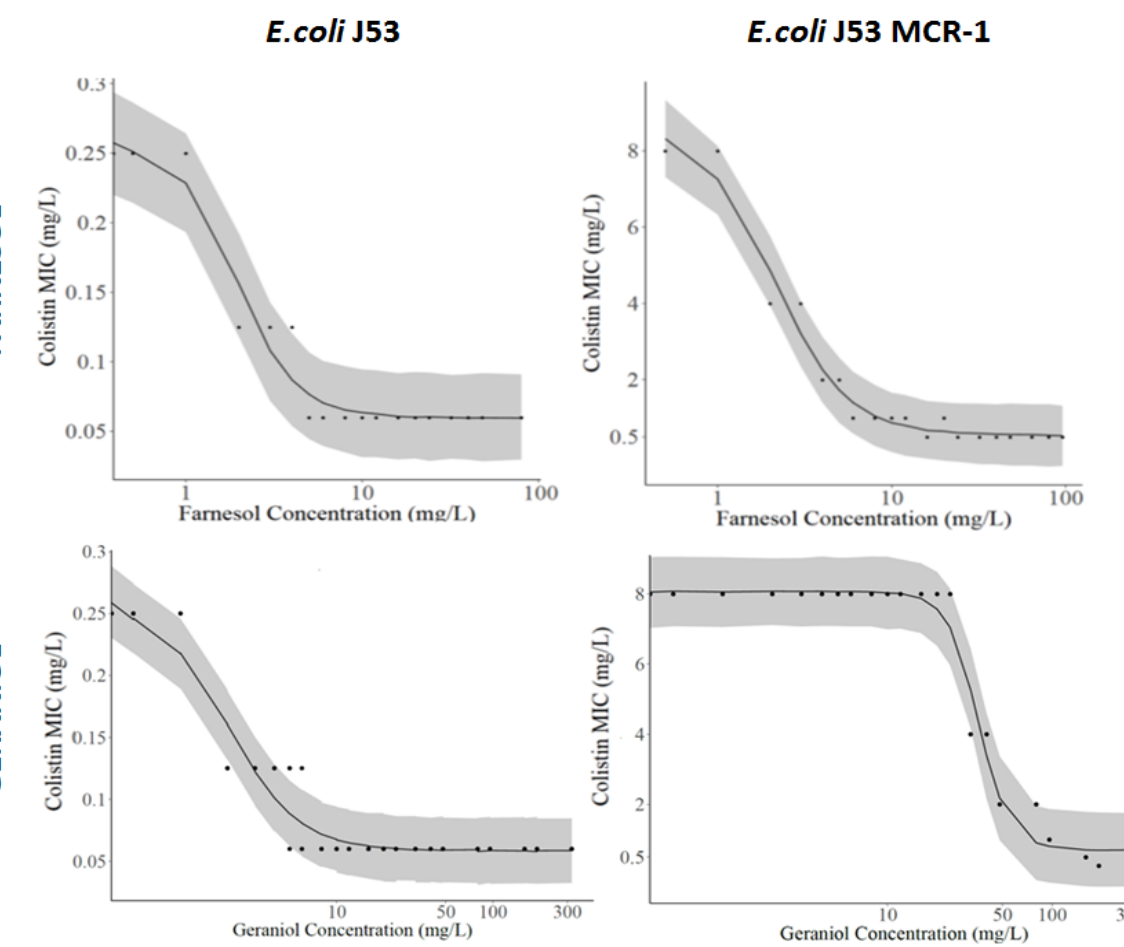
Figure 2. Colistin MIC (mg/L) versus farnesol (top) or geraniol (bottom) concentrations (mg/L) measured for E. coli J53 (left) and the corresponding mcr -1 transconjugate E. coli J53_MCR-1 (right). The shaded area are the 90% credible intervals around the mean values (lines) obtained using the E max model (1). ( n = 3, notice that most of the points are overlayed).